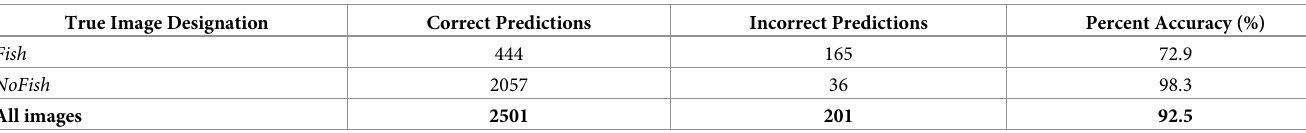
Table 1. Accuracy of model